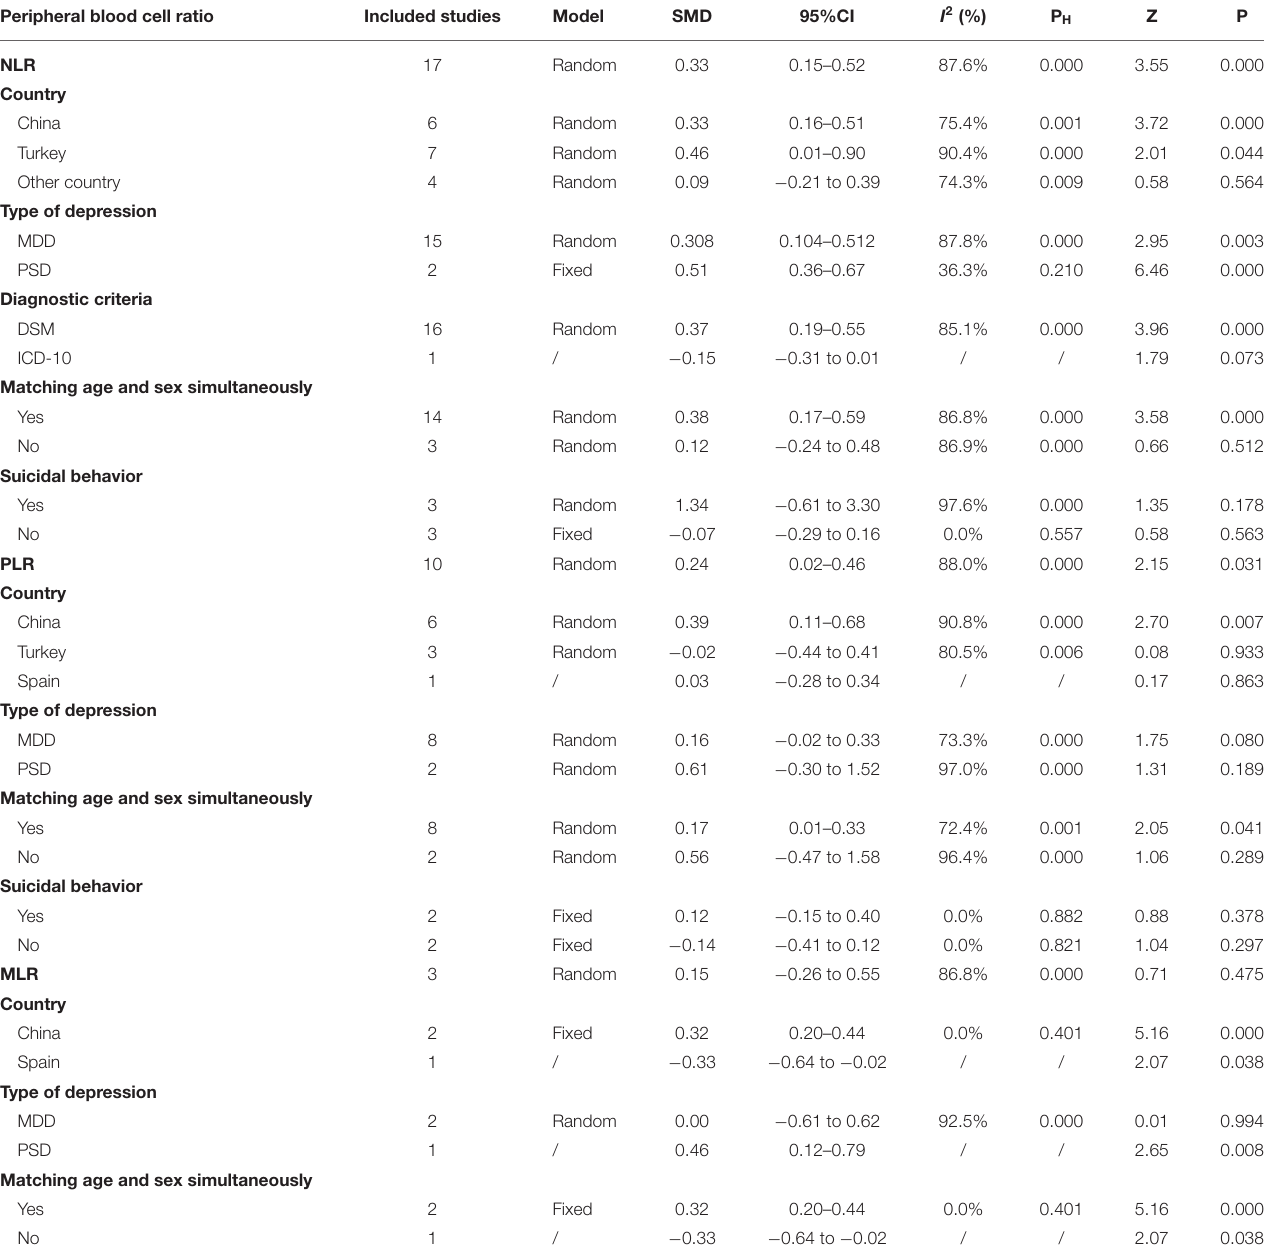
TABLE 3 | Summary of